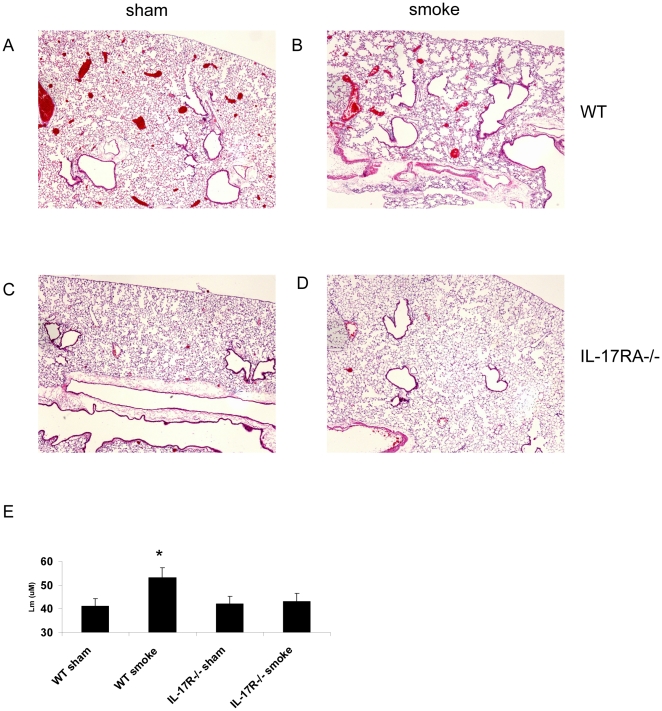
Requirement of IL-17RA for emphysema.Representative histological sections of mouse lungs stained with hematoxylin and eosin after six months of exposure to air (sham exposed) (A,B) or cigarette smoke (C,D) demonstrate C57BL/6 mice develop alveolar enlargement (C) as opposed to IL-17RA−/− mice (D). (E) Enlargement of airspaces was quantified using the mean linear intercept method. This method determines the parenchymal surface area relative to lung volume. An increase in Lm represents an increase in the alveolar space as seen in the WT smoking mice versus sham air. This increase in Lm was not seen in the IL-17A−/− mice over sham air controls. All lung tissues were inflated to 25cm water pressure with neutral buffered formalin. Original magnification: x 50 of representative sections.